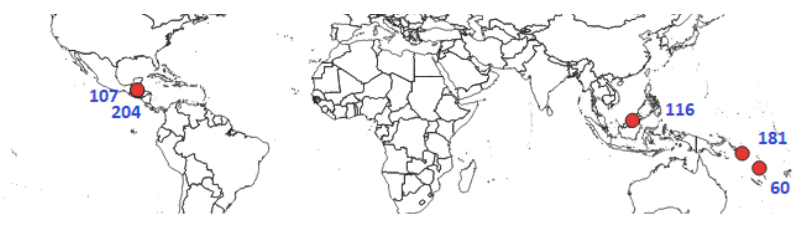
Figure 11. The five sites from which the speleothems originate: 116 (Bukit Assam cave, 6 speleo